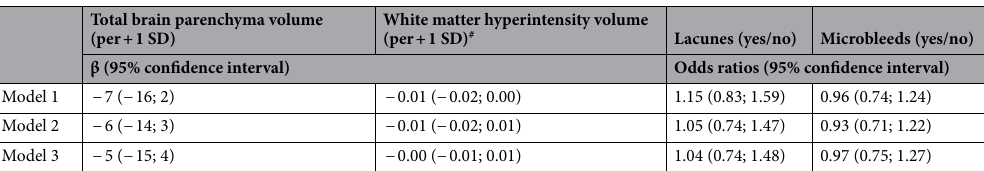
Table 3. Associations between serum N-acetylaspartate levels (per higher standard deviation) and cerebral small vessel disease features. Model 1: unadjusted; Model 2: adjusted for age, sex, education and glucose metabolism status; Model 3: Model 2 + for prior cardiovascular disease, hypertension, smoking and body mass index. Data available in n = 533. # White matter hyperintensity volume was log-transformed.